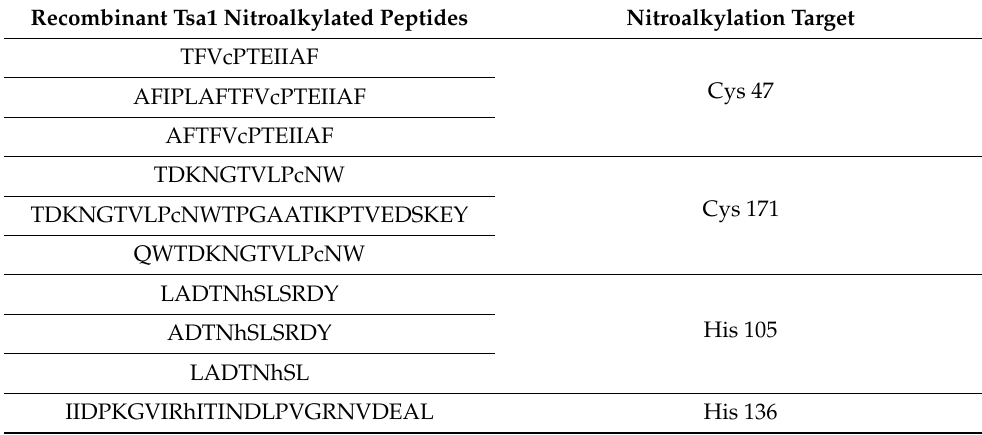
Table 1. Detection by nano-LC-MS/MS of the nitroalkylated peptides of the recombinant Tsa1 treated with NO 2 -OA and the identification of the target residues after the adduction with NO 2 -OA. The position of the nitroalkylation target is highlighted in lowercase. Cys: cysteine; His: histidine.